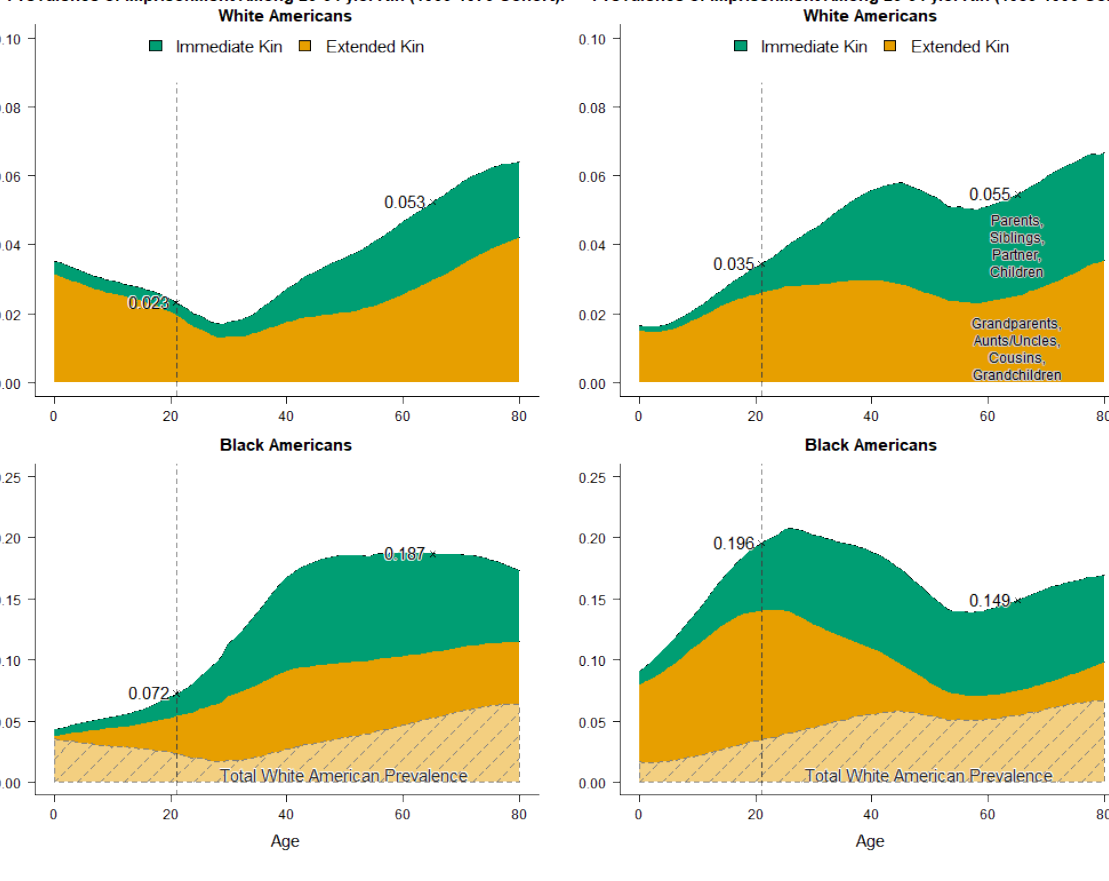
Figure 3: Cohort-specific prevalence of incarceration within kinship networks over age (by relation) among kin who are of working age (25–54 years old). The top plots illustrate the proportion of living kin who have ever been incarcerated for white individuals, whereas the bottom plots illustrate the same for black individuals. Points marked by x’s indicate the proportion of kin ever incarcerated when ego is age 21 and 65. The total prevalence of incarcerated kin in the white population is superimposed on the bottom (black population) plots to aid comparison across the two different y axis